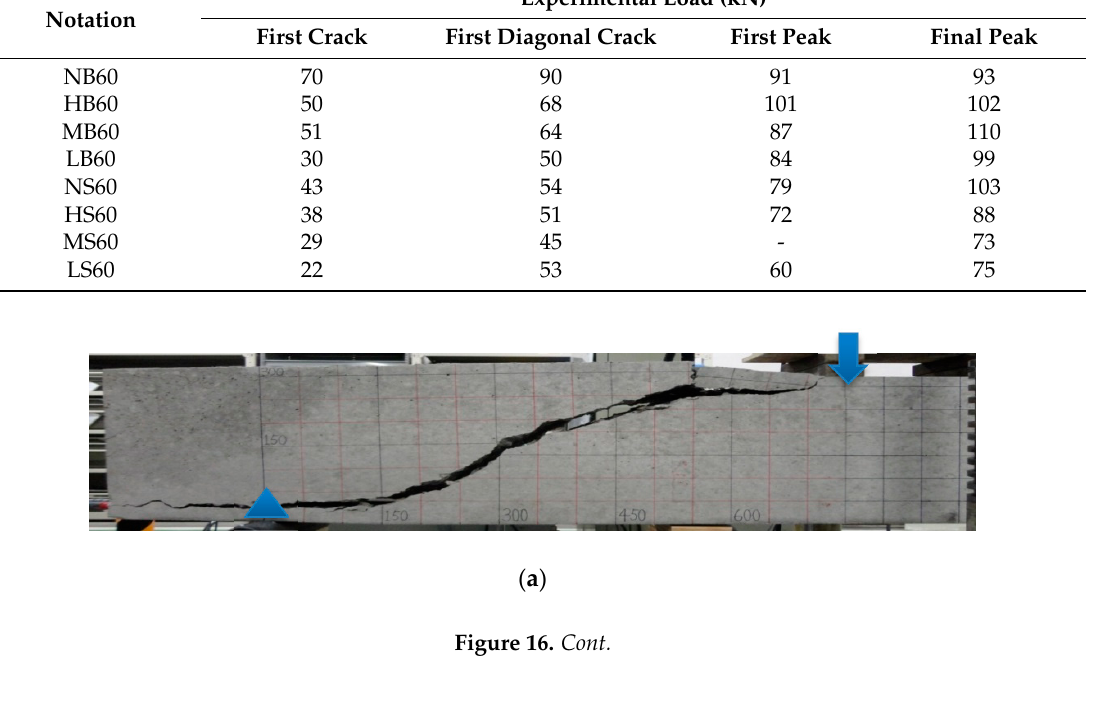
Table 4. Comparison of the experimental load of the reinforced concrete (RC) beam shear testing.